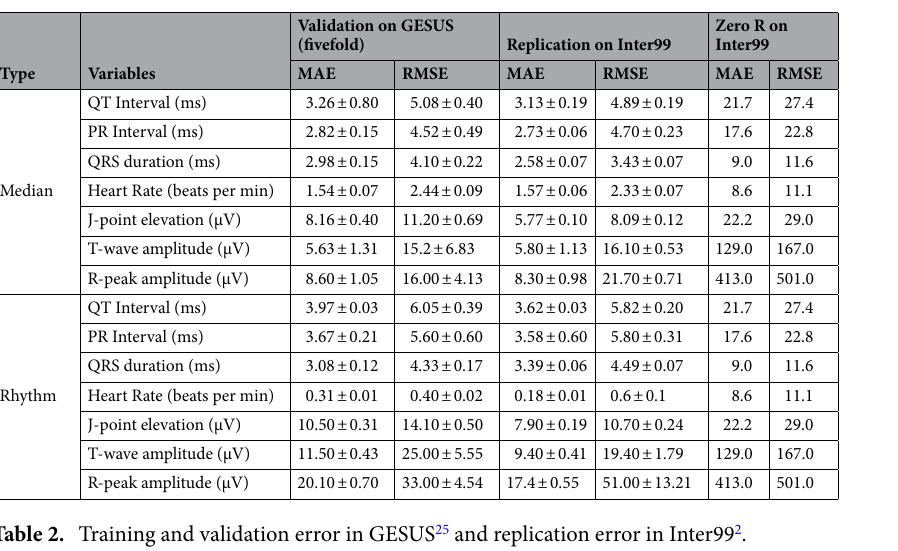
Table 2. Training and validation error in GESUS 25 and replication error in Inter99 2 .